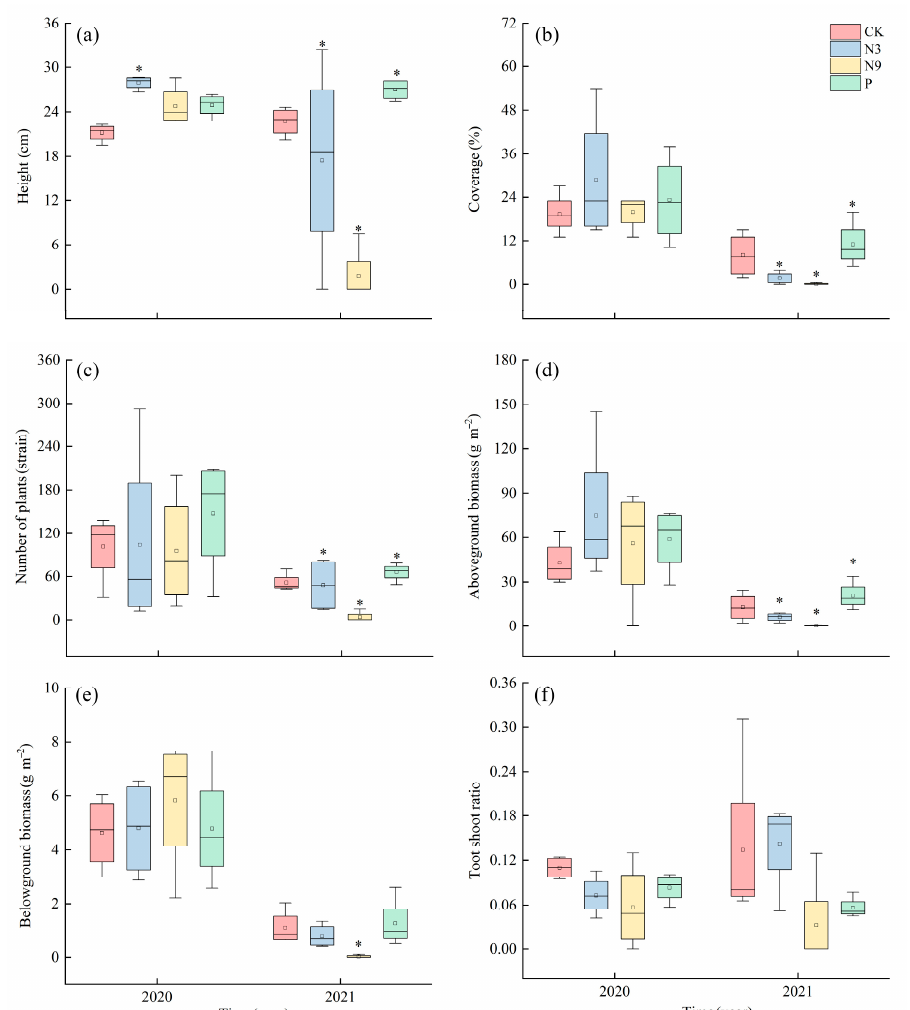
Figure 3. Effects of nutrient addition on P. kansuensis population characteristics. CK: control, no- nutrient addition; N3: low-nitrogen treatment; N9: high-nitrogen treatment; P: phosphate treatment. ( a – f ) is height, coverage, richness, aboveground biomass, belowground biomass, root/shoot ratio. *: there were significant differences between treatments at the level of p < 0.05. The error bars represent a 1.5 range in IQR. The horizontal bars represent the median line. The square represents the mean